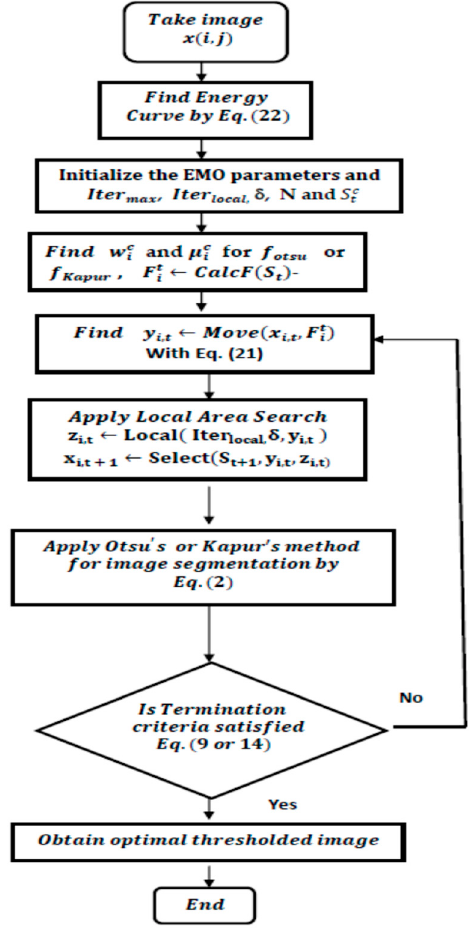
Figure 2. Flow chart of the proposed approach to color image segmentation. The Algorithm for EMO initialization is given below as Algorithm 2. Algorithm 2: EMO initialization